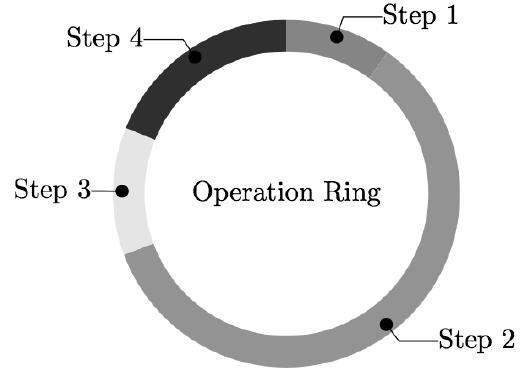
Figure 5. Ideal cycle of the E–W station-keeping